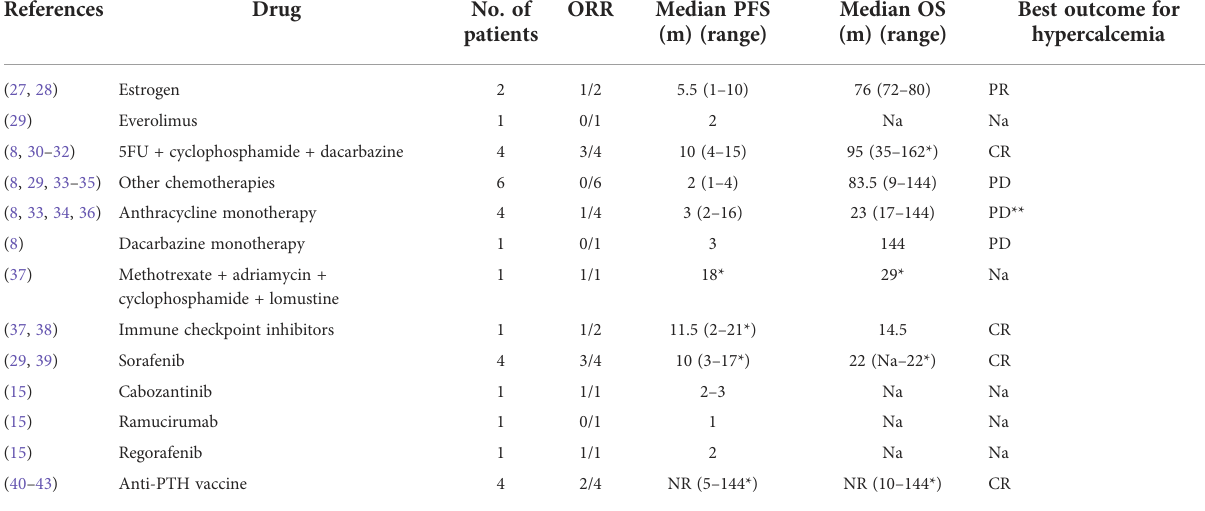
TABLE 2 Systemic therapies